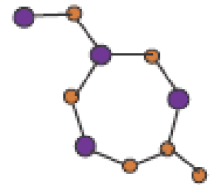
Figure 1. Unit Cell of Si 2 C 3 I [ r, s ]